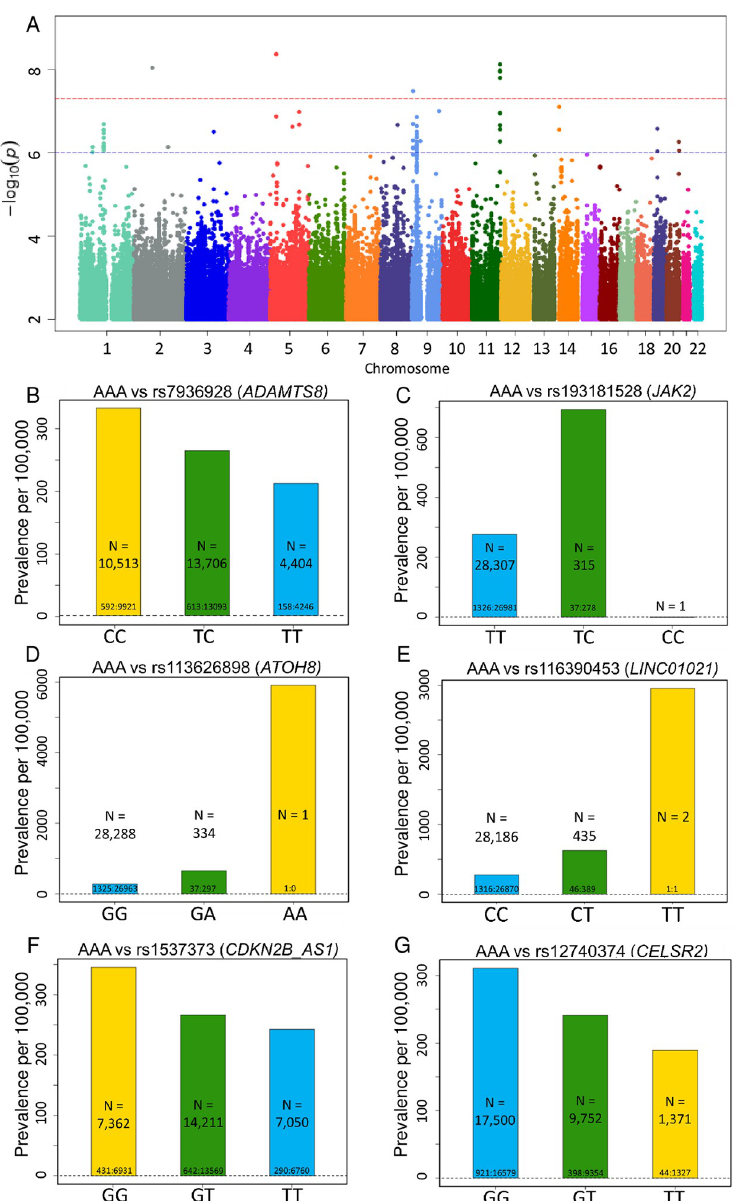
Fig 1. Top SNPs associated with AAA. (A) Manhattan plot of GWAS results (MAF > 0.5%) for AAA. Significance is displayed on the y-axis as -log 10 of the p-value, with results ordered along the x-axis by chromosome (each bar represents a different chromosome). (B-G) Prevalence of abdominal aortic aneurism (AAA) per 100,000 participants in the UK Biobank by genotype. Bars labeled with ratio of cases: Controls. (B) Prevalence of AAA decreases with ADAMTS8 variant rs7936928 status (P-value = 7.51x10 -9 , OR per T allele = 0.786). Decrease in AAA prevalence is noted in the homozygotes for the minor allele (T/T) in comparison to the heterozygotes (C/T) and the noncarriers (C/ C) in a stepwise, “dosage-dependent” manner. (C) Prevalence of AAA increases with JAK2 variant rs193181528 status (P-value = 3.26x10 -8 , OR per C allele = 2.776). (D) Prevalence of AAA increases with ATOH8 variant rs113626898 status (P-value = 9.06x10 -9 , OR per A allele = 2.714). (E) Prevalence of AAA increases with LINC01021 variant rs116390453 status (P-value = 4.26 x10 -9 , OR per T allele = 2.505). (F) Prevalence of AAA decreases with CDKN2B-AS1 variant rs1537373 status (P-value = 6.68x10 -7 , OR per T allele = 0.8211). (G) Prevalence of AAA decreases with CELSR2 variant rs12740374 status (P-value = 2.04x10 -7 , OR per T allele = 0.7668).